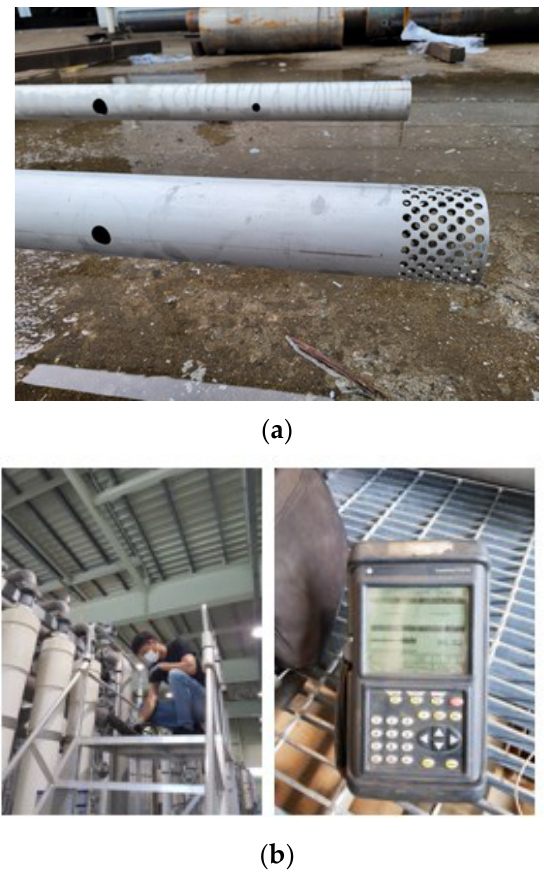
Figure 4. Inner orifice pipes and flow metering: ( a ) inner orifice pipes (Cases A and B); ( b ) metering using ultrasonic liquid flowmeter.